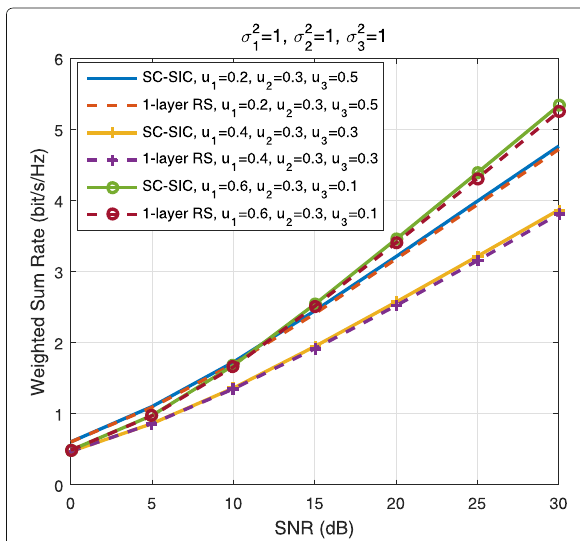
Fig. 44 Weighted sum rate versus SNR comparison of different strategies for overloaded three-user deployment with perfect CSIT, = σ 2 = σ 2 = 1, N = 1, r = [0,0,0.01,0.03,0.1,0.2,0.3] bit/s/Hz σ 2 t th 1 2 3